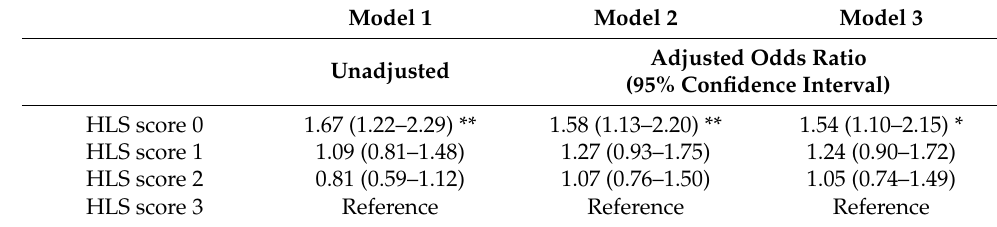
Table 4. Multivariable association between HLS score and periodontal